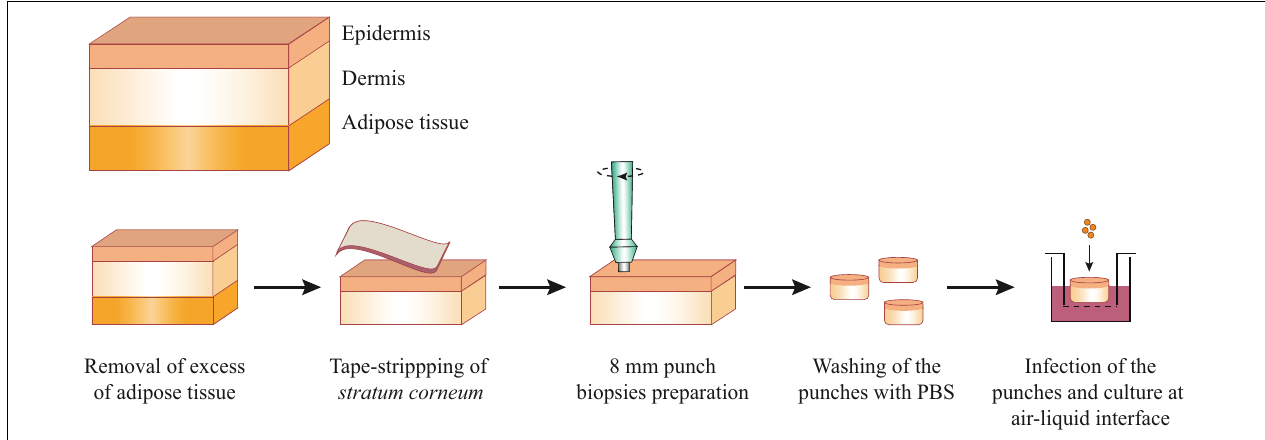
FIGURE 1 | Schematic representation of the protocol to process and infect fresh human skin explants. After removal of the adipose tissue, the skin explants were pinned in a dissection board and the surface of epidermis was tape-stripped with an hypoallergenic tape. Skin punches of 8 mm were prepared, washed in PBS and placed in a transwell, previously filled with culture medium. The skin was infected with 5 × 10 6 CFU of USA300 LAC strain and cultured at air-liquid interface for 2, 3, 24, or 72